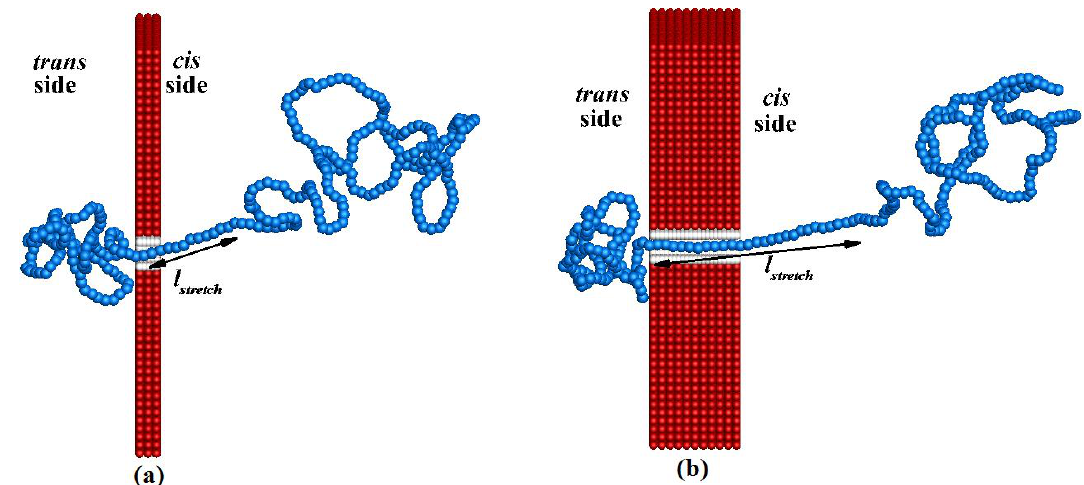
translocating from the cis side to the trans side for pore lengths: ( a ) L ( b ) L = 100 p